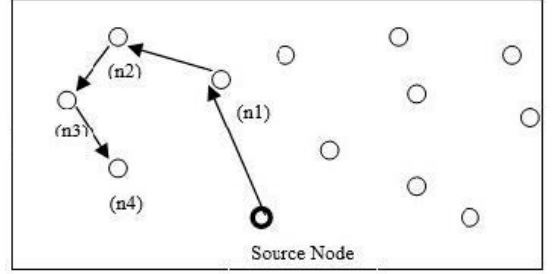
Figure 4. Showing a near to sink phantom node.